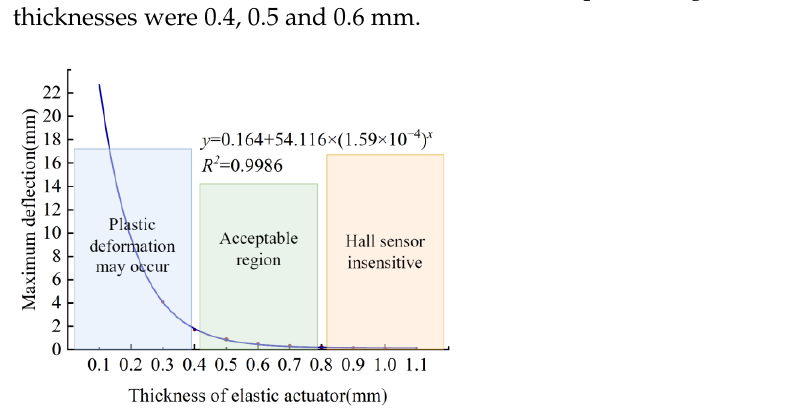
Figure 7. The maximum deflection of elastic actuators of different thicknesses.